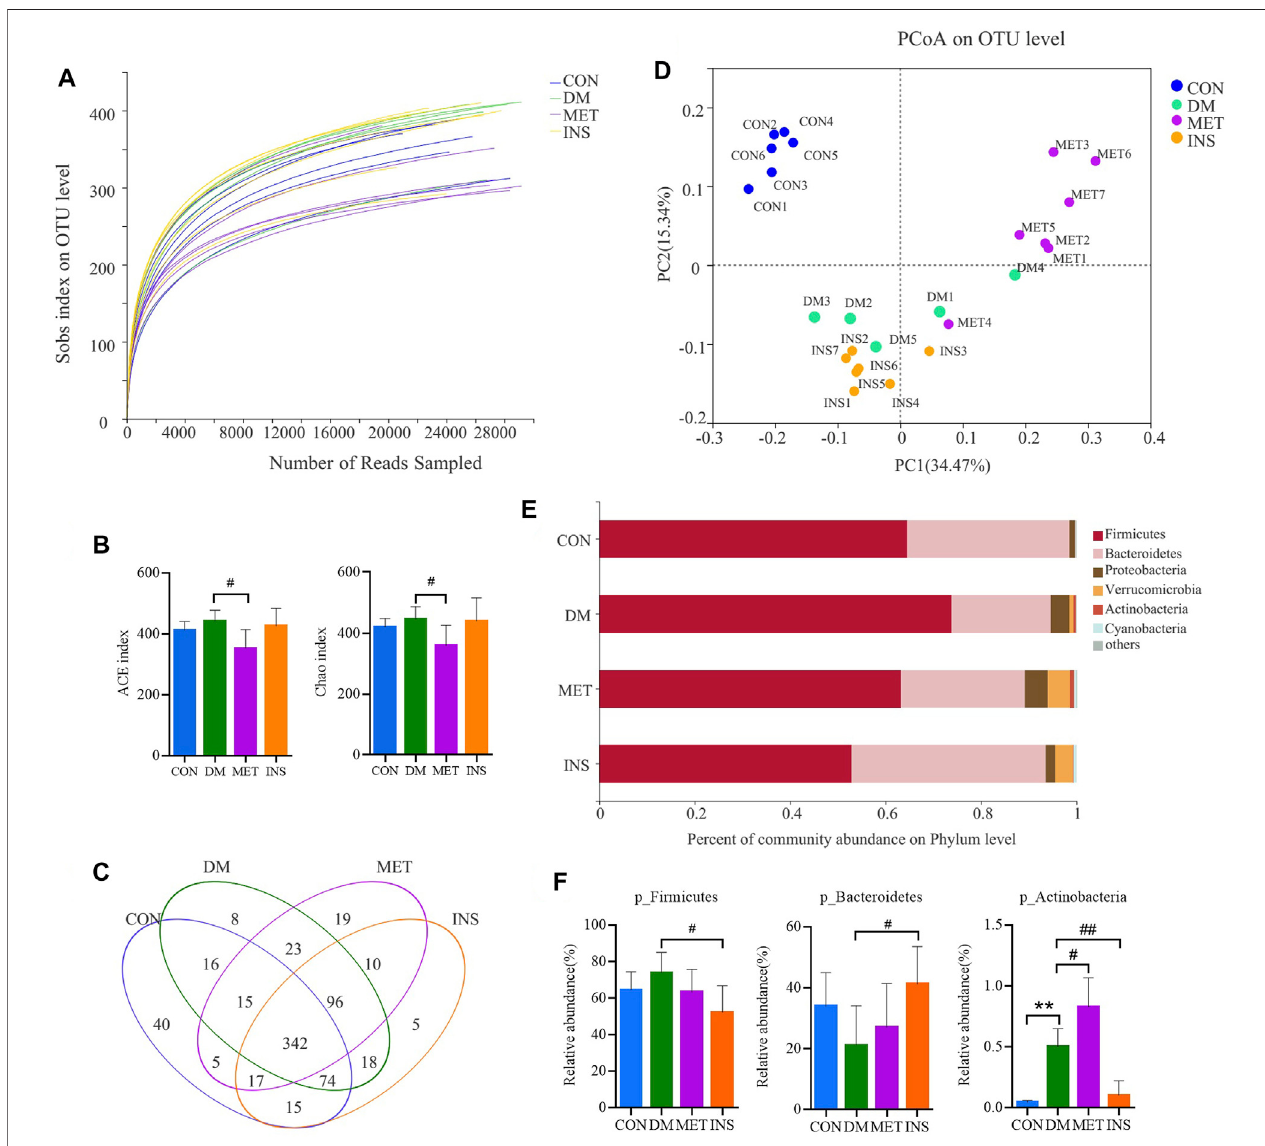
FIGURE 2 | Gut microbiota response to metformin and insulin treatment. (A) Rarefaction curves of the gut microbiota. (B) ACE and Chao index. (C) Venn (D) weighted Unifrac PCoA of gut microbiota based on the OUT abundance (E) Relative abundance of gut microbiota in four groups at the phylum level (F) Relative abundances of Firmicutes, Bacteroidetes and Actinobacteria in different groups. * p < 0.05, ** p < 0.01 vs CON group. # p < 0.05, ## p < 0.01 vs DM group.